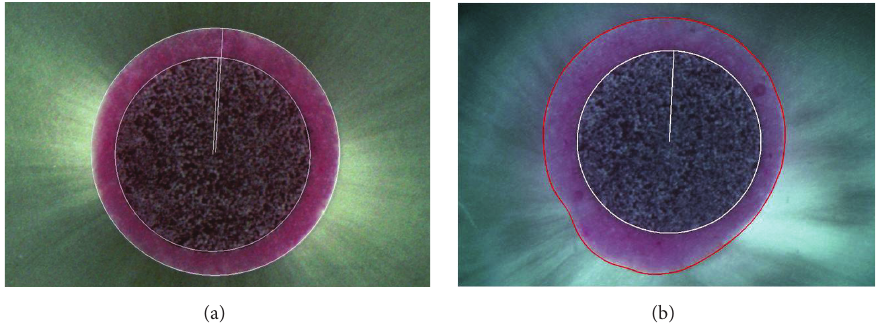
Figure 1: (a) “Circle points” tool used to manually contour the perimeter of the perfectly round post or canals. (b) “Outline spline” tool used to contour the perimeter of oval or irregular canals.